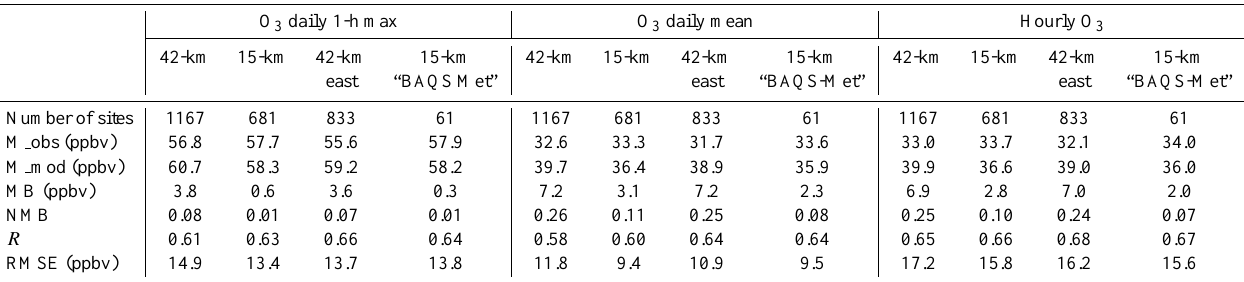
Table 1. Evaluation statistics for 3 June 2007–31 August 2007, 42-km and 15-km AURAMS versus AIRNow. M obs = observed mean,